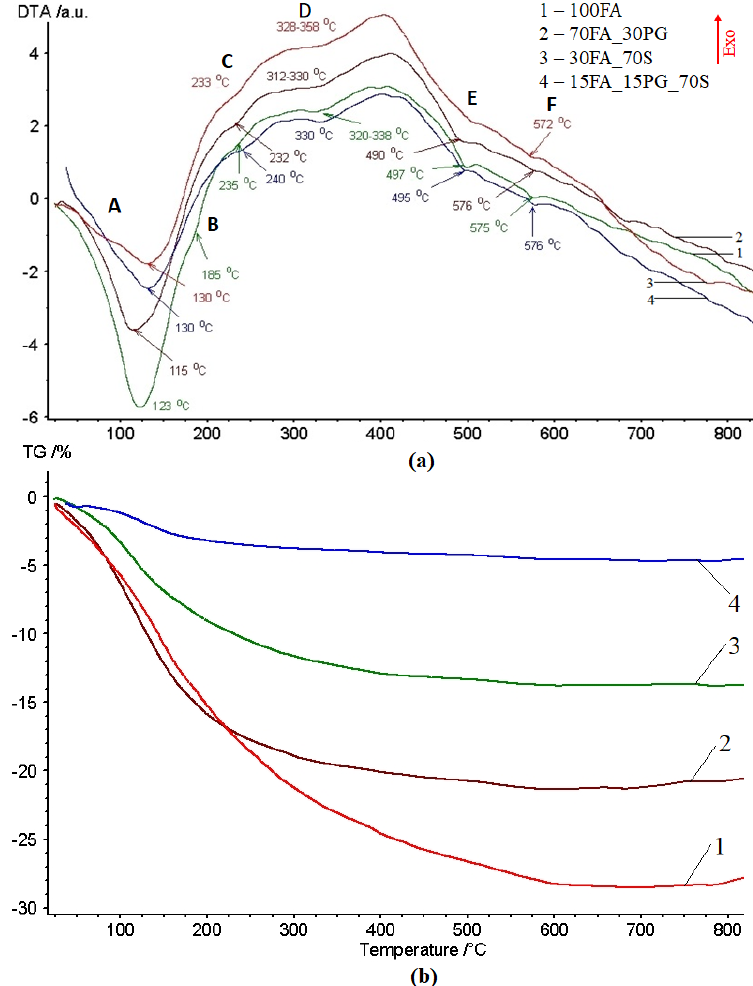
Figure 4. TG-DTA curves in the 22–820 °C temperature range: ( a ) DTA curves; ( b ) TG curves.